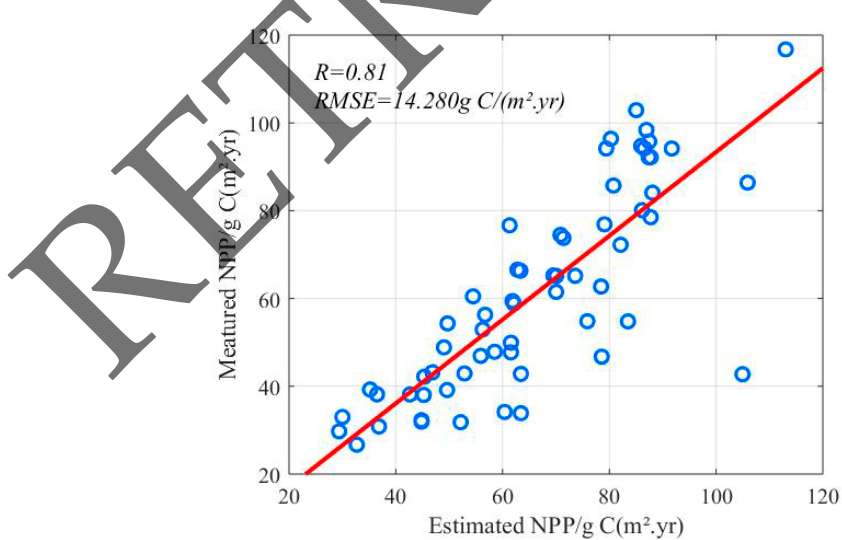
Figure 10. Comparison between the estimated NPP and MOD17A3H NPP.